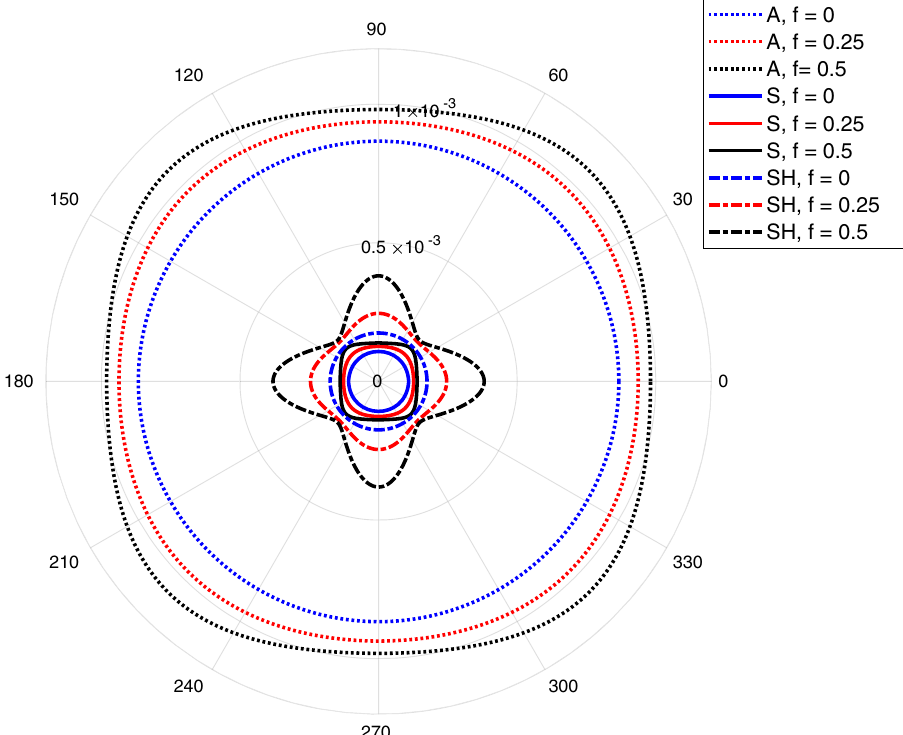
Fig. 3 Radial plot of the slowness surfaces (k/ ω vs ϕ ) of the three lowest modes of the holey SiN PnC metaplate. The lowest modes (A, S, and SH) are shown for three fi lling factors f = 0, 0.25, 0.5. For the fl exural A-mode, slowness is a function of frequency, here plotted for a thermally relevant frequency ω =